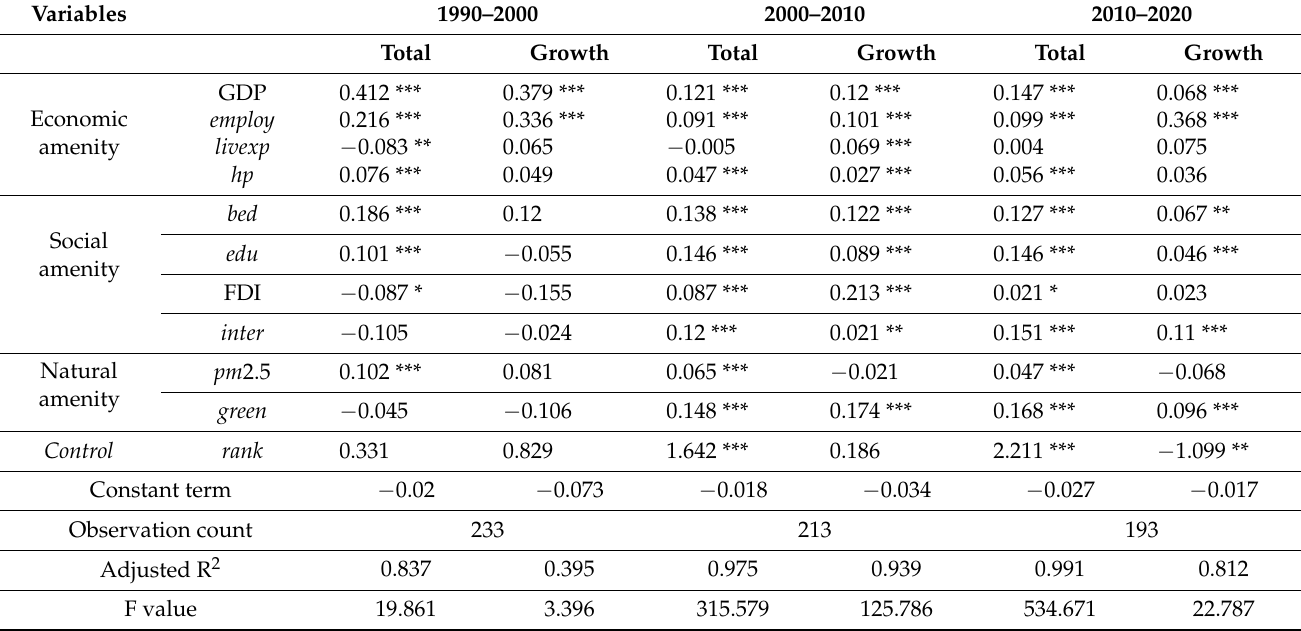
Table 2. Results of regression